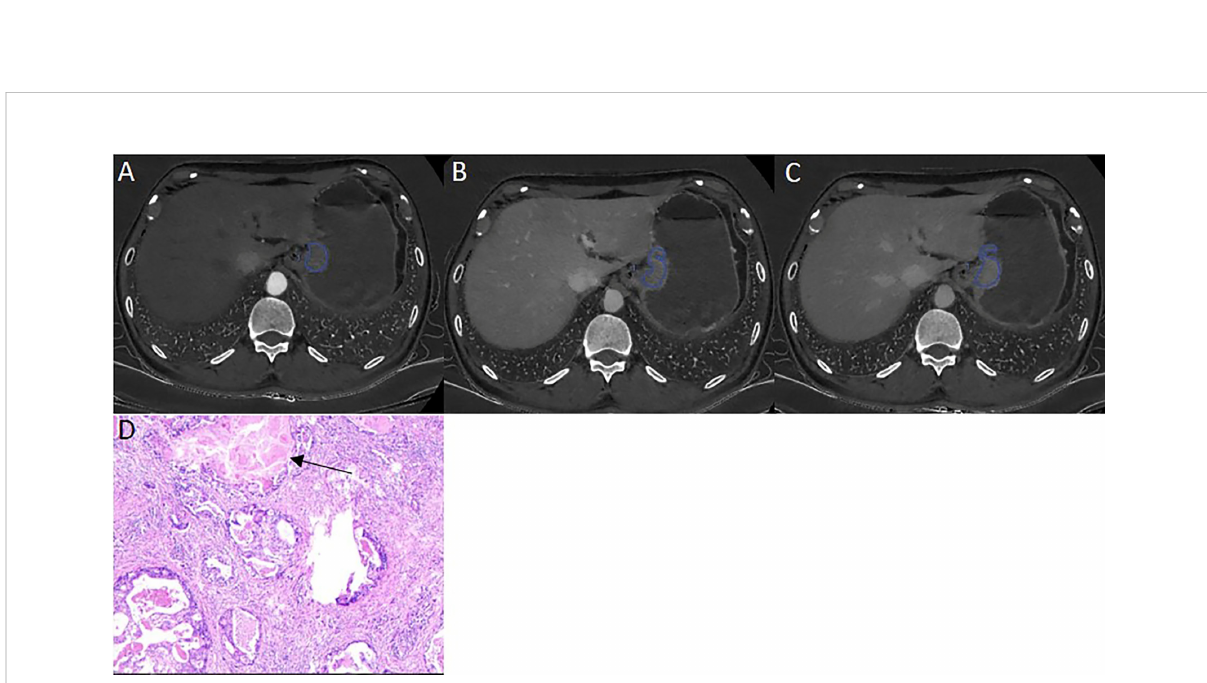
FIGURE 3 A 46 years old male patient with pathologically con fi rmed gastric adenocarcinoma, staging of pT3N0M0, LVI negative. The tumor thickness was 18.23 mm, Borrmann classi fi cation of III. (A) Iodine map at arterial phase, tumor was hyperintense, IC value was 21.34(100 m g/ml); (B) Iodine map at venous phase, IC value was 37.65(100 m g/ml); (C) Iodine map at delay phase, IC value was 33.40 (100 m g/ml); (D) The histopathology (HE, magni fi cation: ×200) showed normal lymphovascular structure